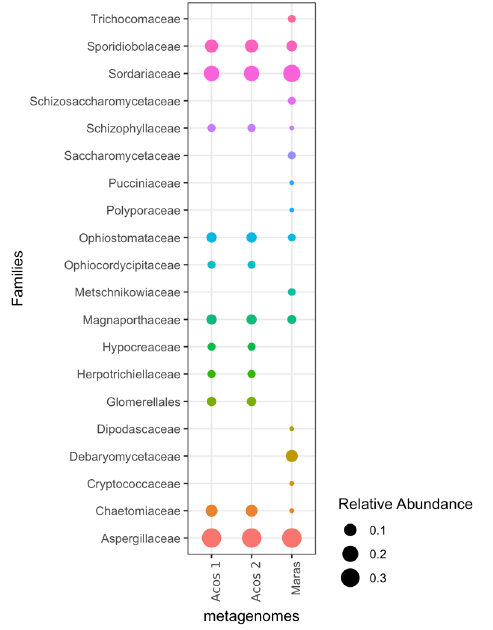
Figure 5. Diversity taxonomy of fungi. The Aspergillaceae family was the most abundant in Acos and